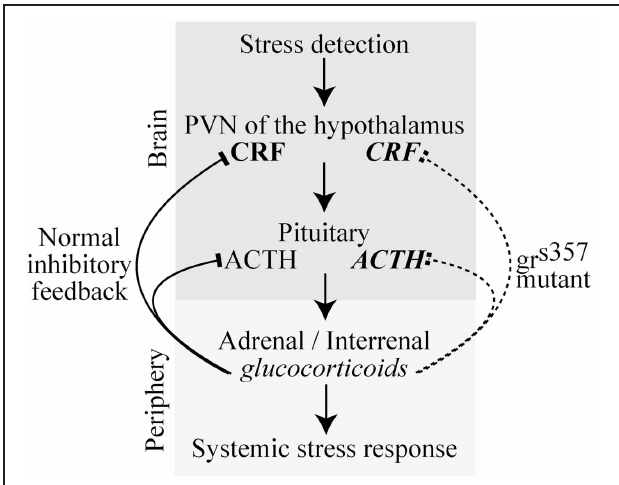
FIGURE 1 | A simplified schematic of the vertebrate HPA stress pathway in normal and gr s357 mutant zebrafish in which the glucocorticoid receptor is non-functional. Lines with arrowheads indicate feed forward excitation and lines with blocked heads indicate feedback inhibition. Regular font signifies neural structures and italicized font signifies diffusible signaling molecules. Glucocorticoid feedback from the periphery to the brain normally inhibits further brain stress activity by transcriptional suppression of genes including those encoding CRH and ACTH (left, solid lines). In gr s357 mutant zebrafish, the glucocorticoid receptor is non-functional, preventing negative feedback (right, dashed line), and leading to prolonged release and higher levels of stress intermediaries (bold font). Abbreviations: CRH, Corticotropin releasing hormone; ACTH, Adrenocorticotropic hormone; HPA, Hypothalamic-pituitary-adrenal axis; PVN, Paraventricular nucleus.